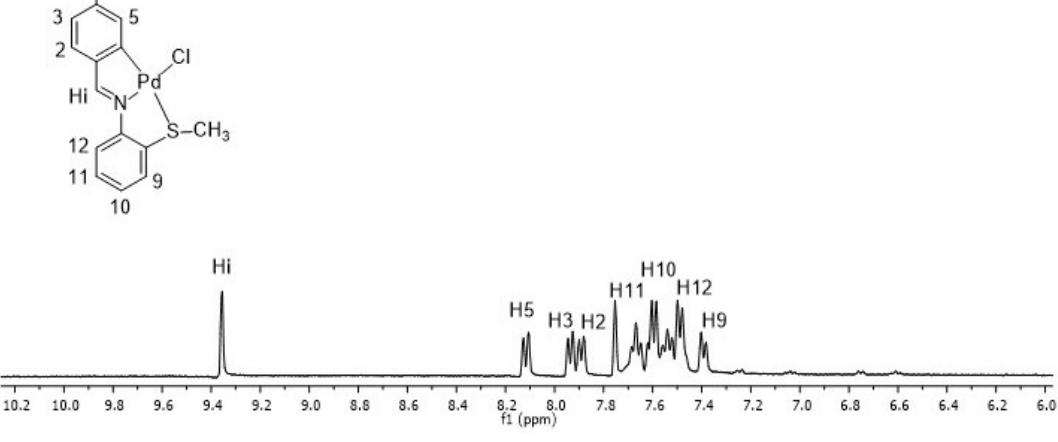
Figure 2. 1 H NMR spectrum of compound 1a in DMSO-d6.